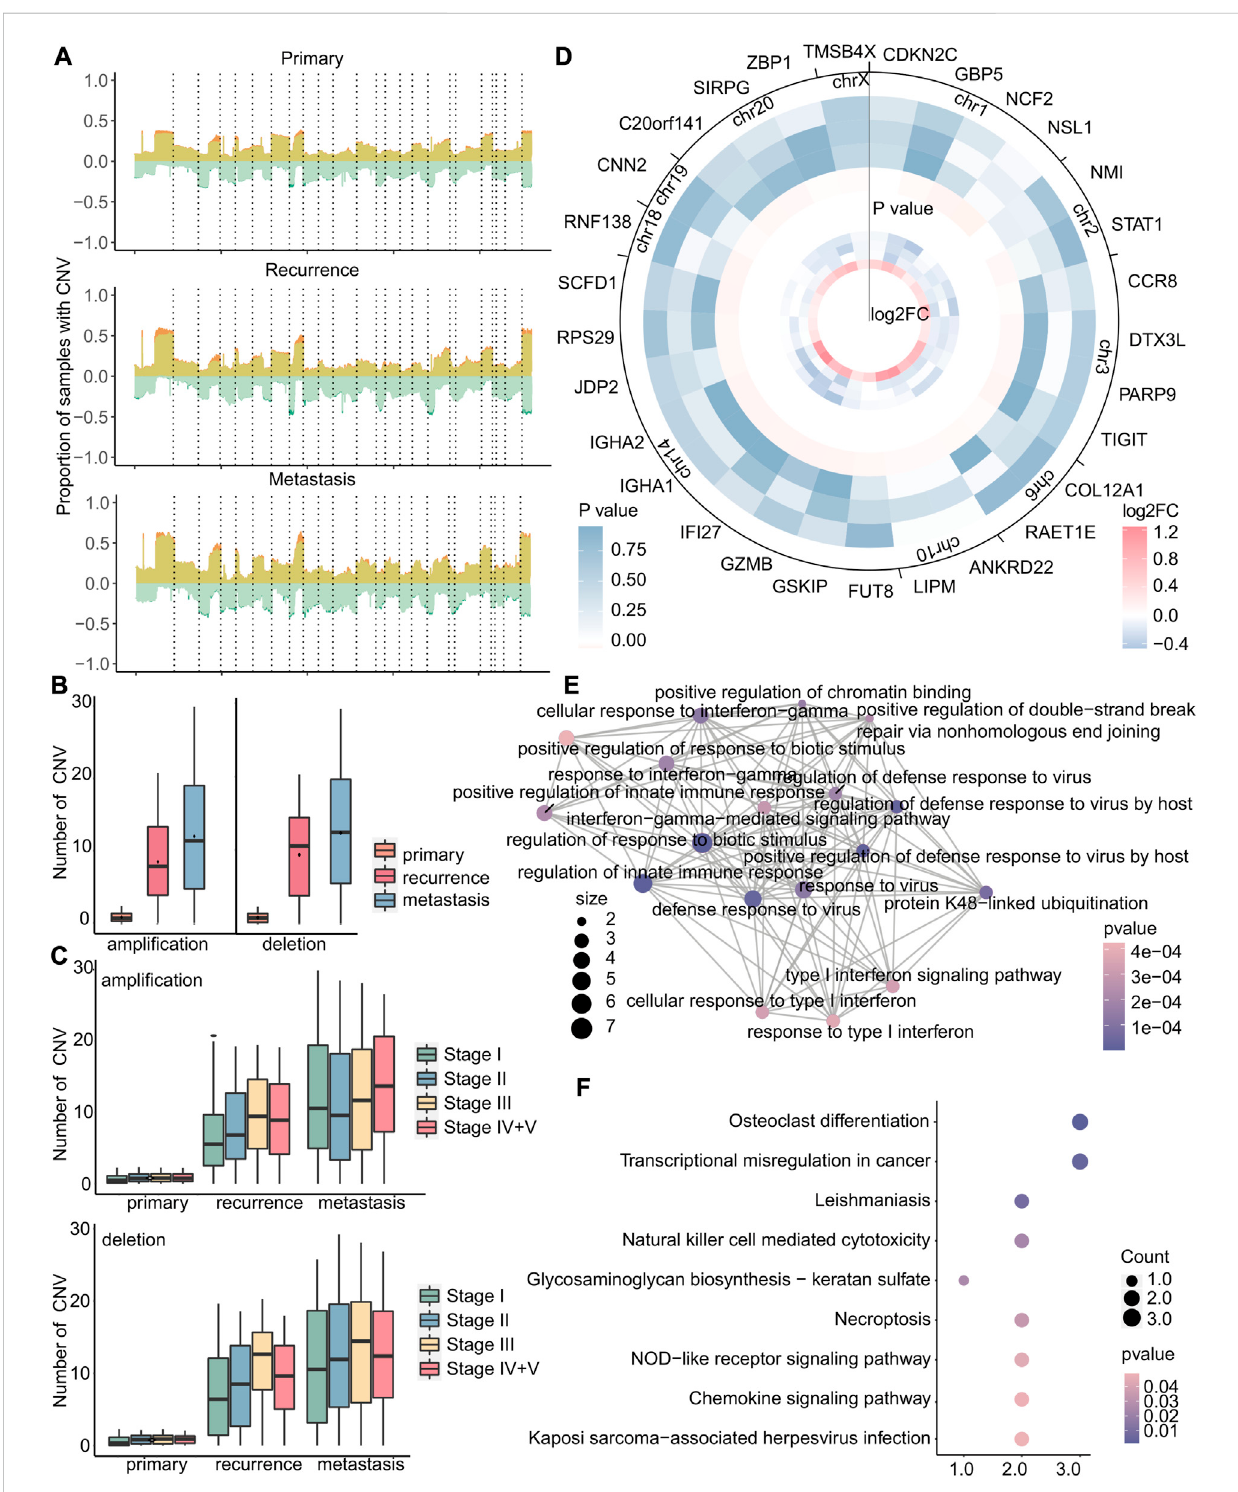
CopynumbervariationinstageImetastatictumorsismorecomplicated. (A) Forprimary,recurrent,andmetastaticsamplesofstageI,theproportion of samples with copy number variations to the totalsamples. The upper part of 0indicates thecopynumber ampli fi cation rate,whichwas thesum of the low-levelcopynumberampli fi cationrateinlightyellow,andthehigh-levelcopynumberampli fi cationrateisindarkyellow.Thelowerpartof0indicated the copy number deletionrate, whichwas zero minus its true value. The mutation rate is the sum of thesingle-copy deletionrate in light green, and thehomozygousdeletionrateisindarkgreen.Dottedlinesseparateddifferentchromosomes. (B – C) Boxplotofthenumberofampli fi cationsordeletions in each sample. (D) In metastatic tumors, heatmap of the log 2 FC value of speci fi c copy number variant genes in stage I (small) and heatmap of Fisher ’ s exact test p -value (large). Stages I, II, III, and IV + V of cancer from the inside to the outside. (E – F) GO enrichment analysis and KEGG enrichment analysis of29genes.Eachdotrepresentsapathway,andtheconnecting twopointsmeanthatthesamegeneswereinthepathways. Thesizeofthedotindicates the number of genes in these 29 genes, and the color of the dot indicates the p